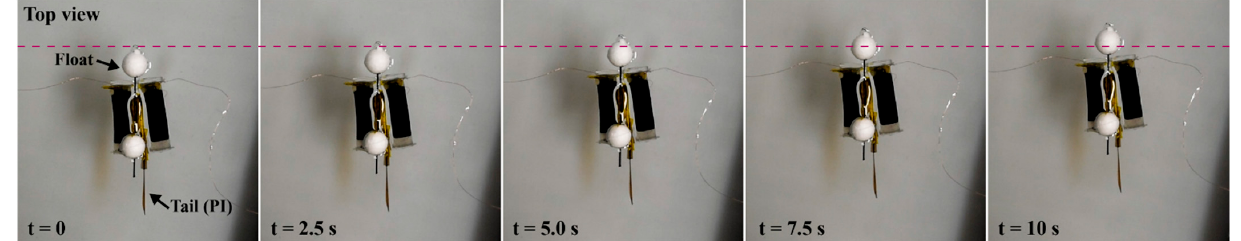
Figure 7. Sequence of the swimming of robot (voltage 1000 V, driving frequency 10 Hz).